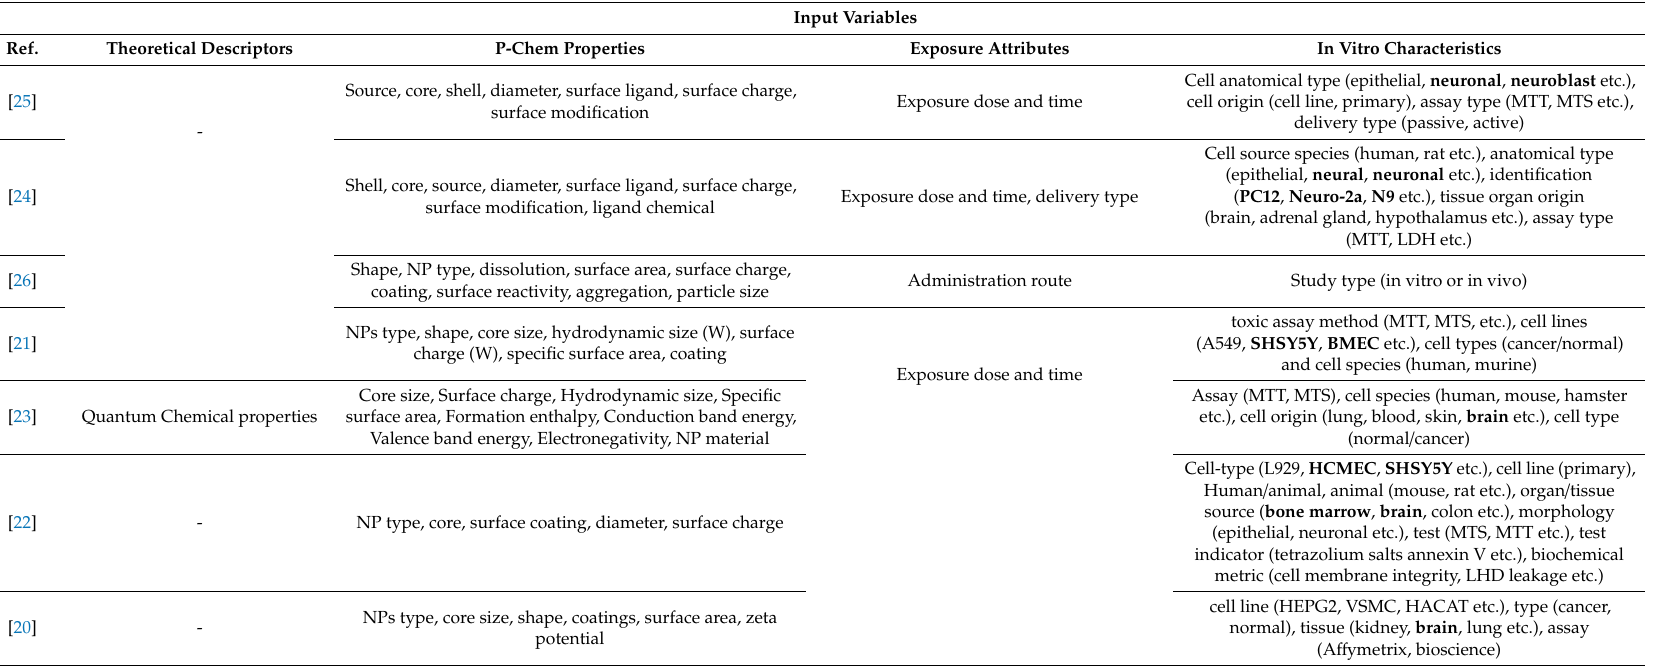
Table 6. In silico available tools in the literature capturing neurotoxicity (relevant features in bold). The final input variables selected for model implementation are categorized in theoretical descriptors, p-chem properties, exposure attributes and in vitro